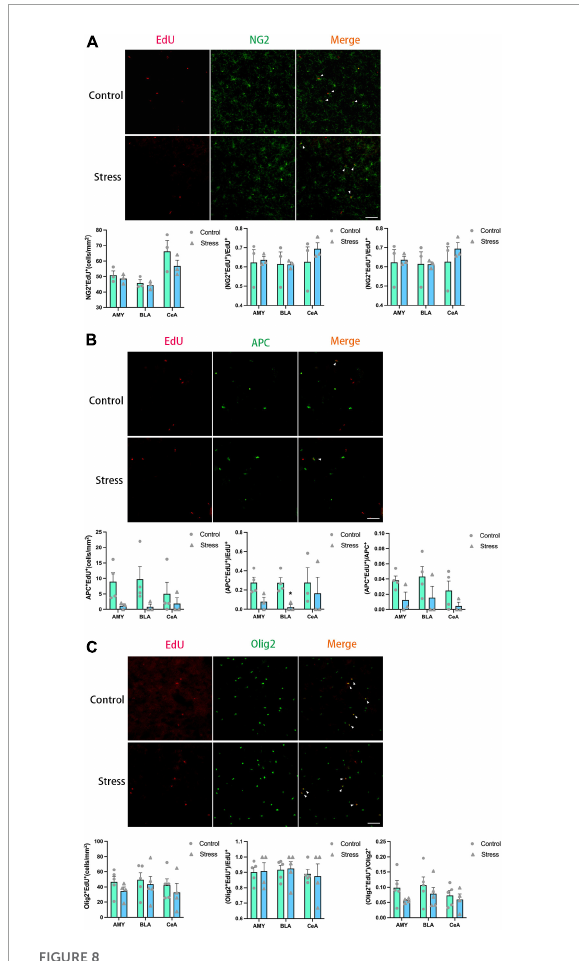
FIGURE8 Chronic social defeat stress (CSDS) exerts little effects on oligodendrogenesis in the amygdala (AMY) of adolescent mice. (A) Representative images (upper panels) of newly generated cells (EdU + ; red), OPCs (NG2 + ; green), and newly formed OPCs (NG2 + EdU + ; orange) in the AMY and the bar graphs (lower panels) showing the number of NG2 + EdU + , the percentage of NG2 + EdU + in the total EdU + cells, and the percentage of NG2 + EdU + in the total NG2 + cells in the total AMY area and its subregions. The white arrowhead indicates the newly formed OPCs. (B) Representative images (upper panels) of newly generated cells (EdU + ; red), mature OLs (APC + ; green), and newly formed mature OLs (EdU + APC + ; orange) in the AMY and the bar graphs (lower panels) showing the number of APC + EdU + , the percentage of APC + EdU + in the total EdU + cells, and the percentage of APC + EdU + in the total APC + cells in the total AMY area and its subregions. The white arrowhead indicates the newly formed mature OLs. (C) Representative images (upper panels) of newly generated cells (EdU + ; red), OLLs, (Olig2 + ; green), and newly formed OLLs (EdU + Olig2 + ; orange) in the AMY and the bar graphs (lower panels) showing the number of Olig2 + EdU+, the percentage of Olig2 + EdU+ in the total EdU + cells, and the percentage of Olig2 + EdU + in the total Olig2 + cells in the total AMY area and its subregions. The white arrowhead indicates the newly formed OLLs. Magnification: 100 × . Scale bars: 50 µ m. Data are expressed as mean ± SEM. The number of animals used is as follow: NG2 + EdU + (control, n = 3; stress, n = 3); APC + EdU + (control, n = 4; stress, n = 3); Olig2 + EdU + (control, n = 5; stress, n = 4). * P < 0.05, Stress vs.